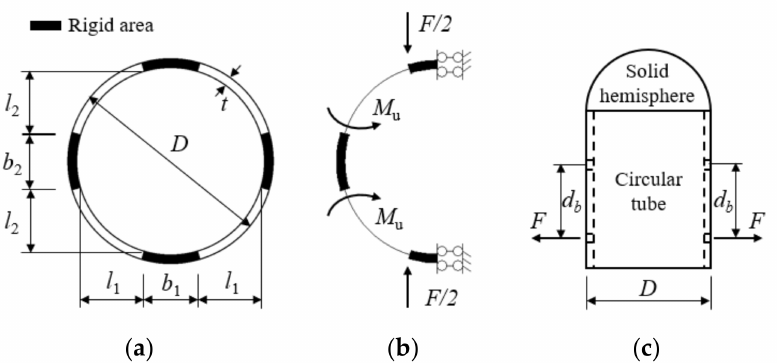
Figure 21. Analytical model for BBC joint capacity: ( a ) geometry; ( b ) under compression; ( c ) under positive